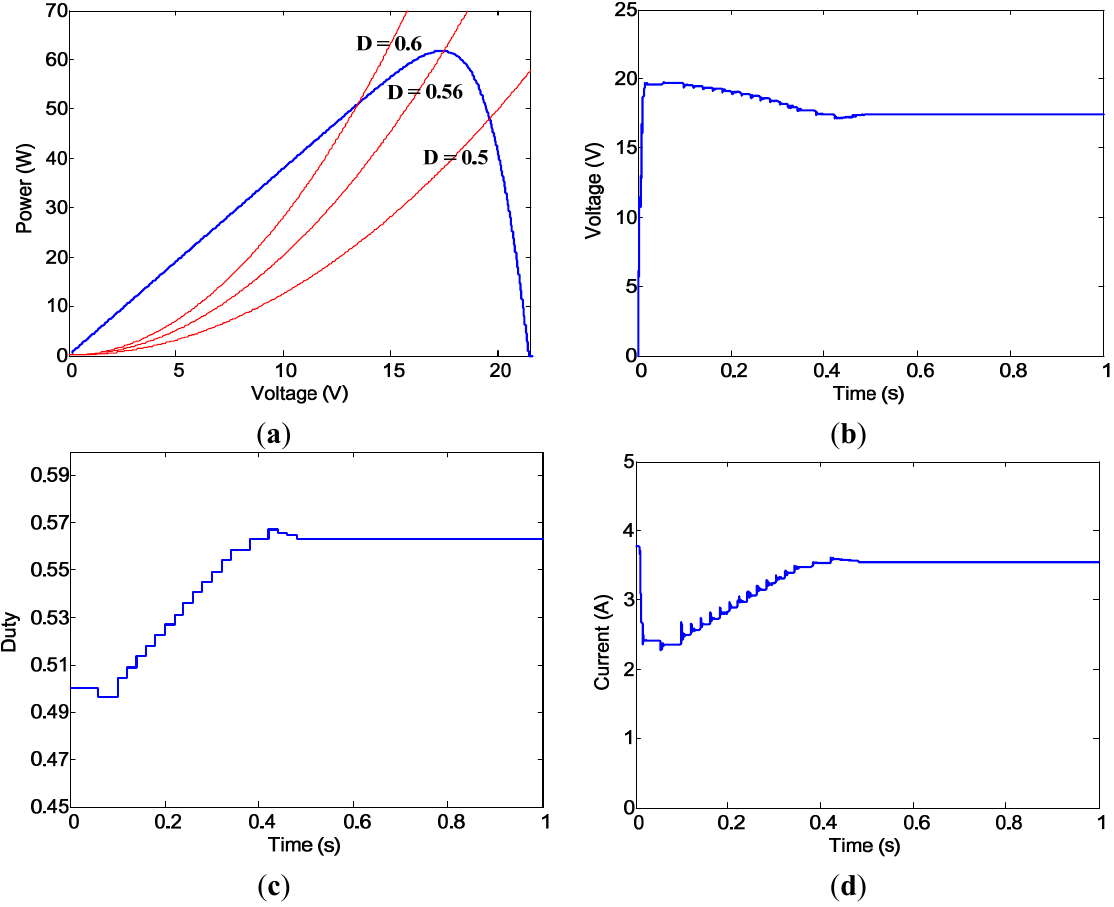
Figure 16. Circuit simulation results with 8  load. ( a ) Power characteristics; ( b ) Duty ratio command; ( c ) Output voltage from PV model; ( d ) Output current from PV model.